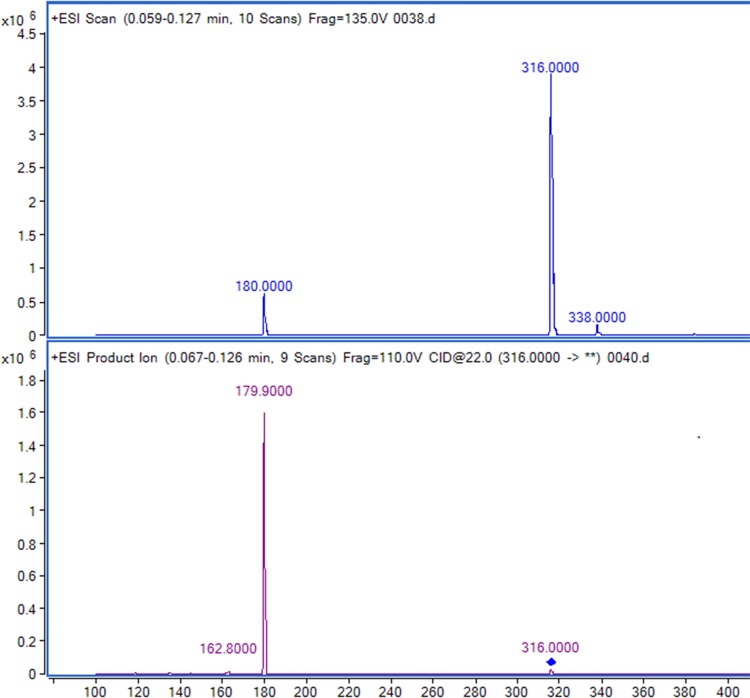
Full-scan and product ion scan mass spectrogram of saxagliptin.